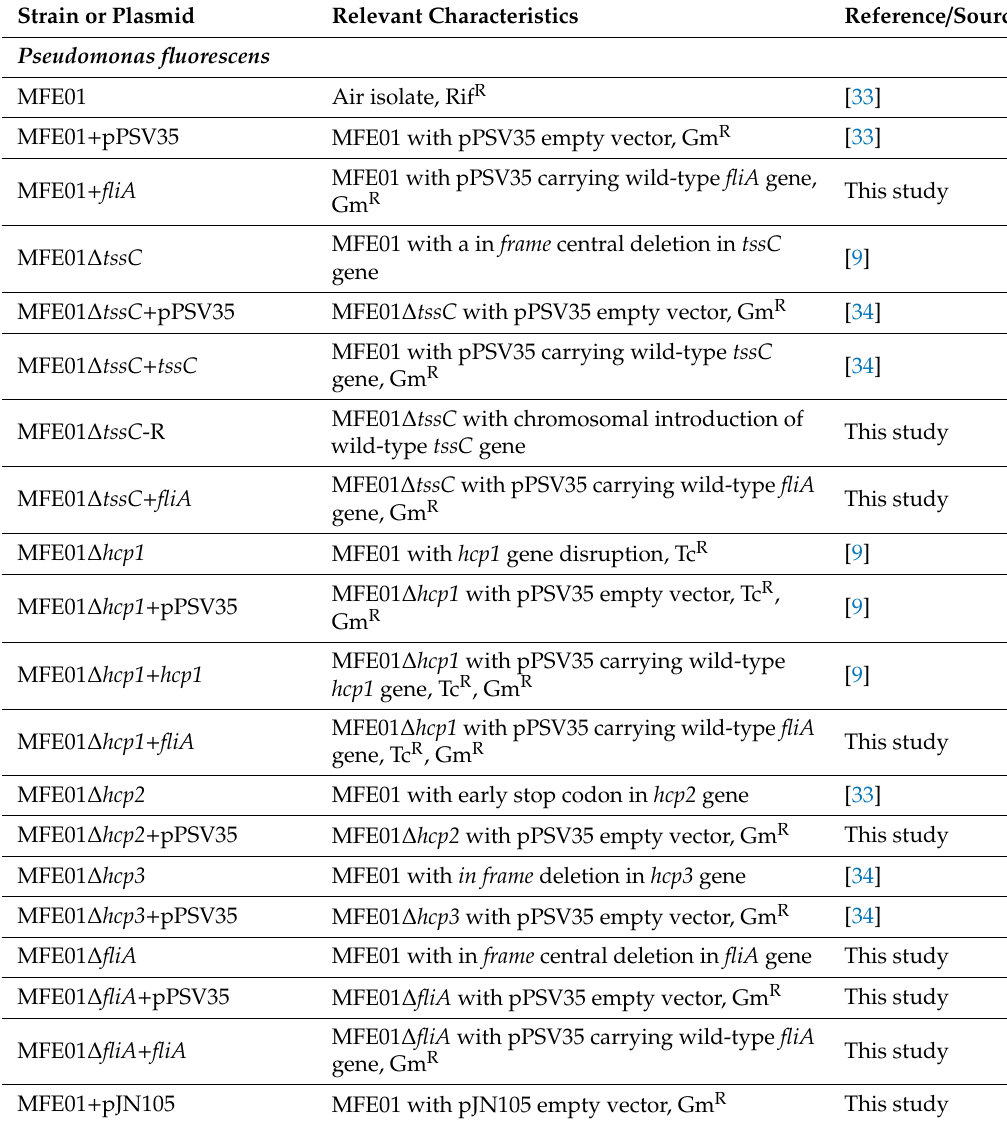
Table 1. Strains and